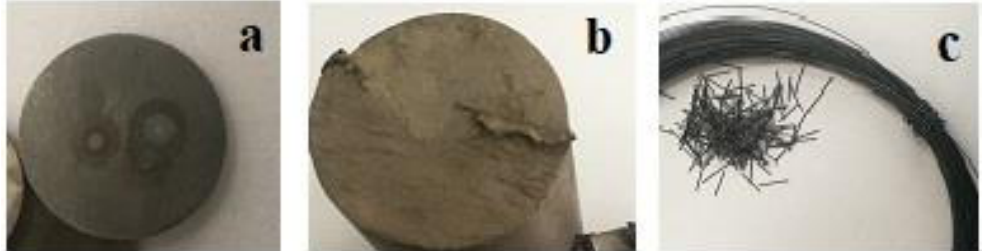
Figure 2. Materials used in the VAR process for obtaining Ti-19Mo-xW samples. Materials used in the VAR process for obtaining Ti-19Mo-xW samples: ( a ) Titanium; ( b ) Molybdenum; ( c ) Tungsten.